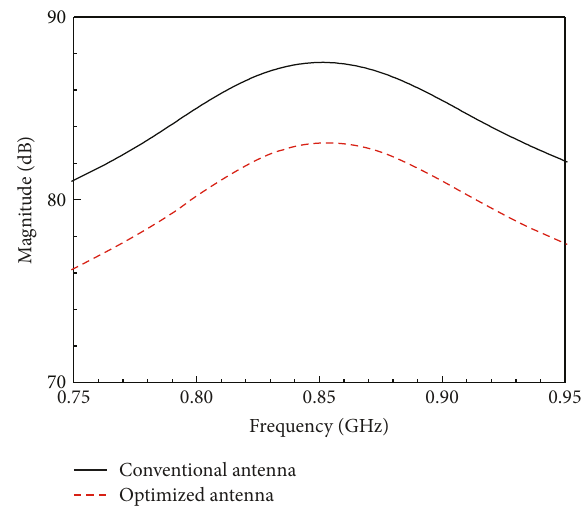
Figure 9: Simulated magnitudes of the electric fi elds at the center of g 2 in the conventional and optimized